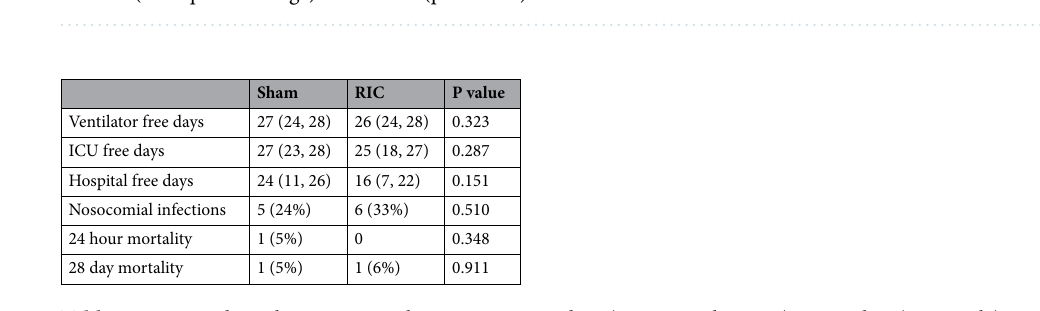
injury to initiation of the intervention, suggesting the complexity of injuries and the patients’ pathological condi- tions contribute to the variability and delay in the application of RIC. The median duration for transport time from the arrival to scene of injury to admission was 25 min (IQR: 15, 34) by ambulance and 70 min (IQR: 51, 85) by helicopter. Those patients who had prolonged transport time were due to transfers from other hospitals. These data suggest there is potentially sufficient time for pre-hospital application of RIC during EMS transport. Neutrophil oxidative burst, adhesion molecules, and MPO (Figs. 2 and 3). Unstimulated neutro- phil ROS production was lower at Admission in the Sham (P < 0.05) and RIC groups (P = 0.079) and remained significantly lower at 1 and 3 h compared to healthy controls. By 24 h, ROS did not differ from healthy controls (Fig. 2A). In RIC treated patients, unstimulated ROS production decreased significantly at 3 h post intervention in comparison to Admission values. PMA-stimulated neutrophil ROS from trauma patients exposed to Sham intervention was significantly higher than healthy controls on admission and gradually fell, becoming no dif- ferent from healthy controls by 3 h. ROS elaborated by PMA stimulated neutrophils from RIC-treated patients similarly fell over the first 24 h and at no time point did this significantly differ from Sham treated trauma patients. (Fig. 2B). Patients receiving the RIC intervention had significantly lower PMA stimulated ROS produc- tion at 24 h post intervention in comparison to healthy controls, a finding that was also seen in the Sham group, although not statistically significant (P = 0.408). Neutrophil ROS in response to fMLP was significantly lower